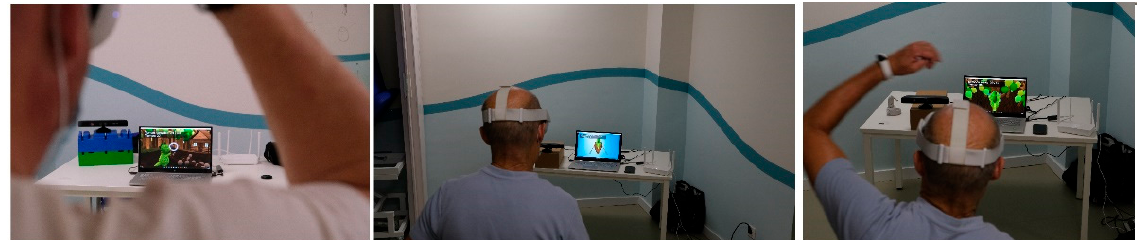
Figure 5. Patient playing “Chop the Wood”, “Row the Boat” and “Climb the Tree”, respectively.